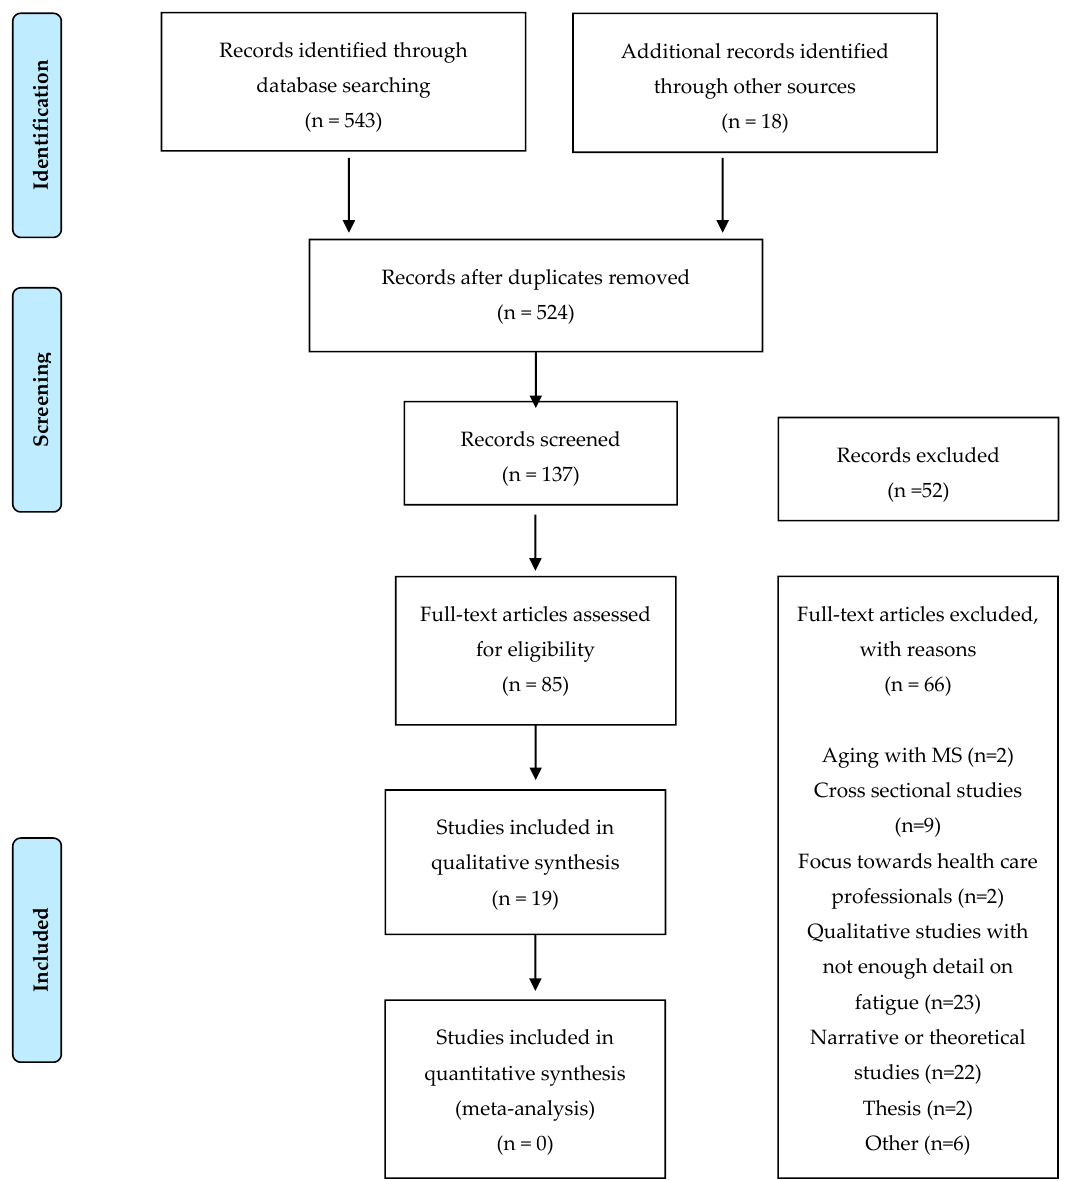
Figure 1. PRISMA